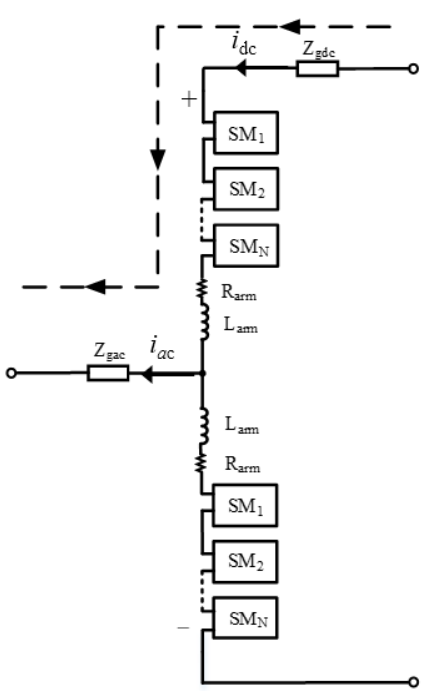
Figure 5. Equivalent circuit of MMC one phase arm.